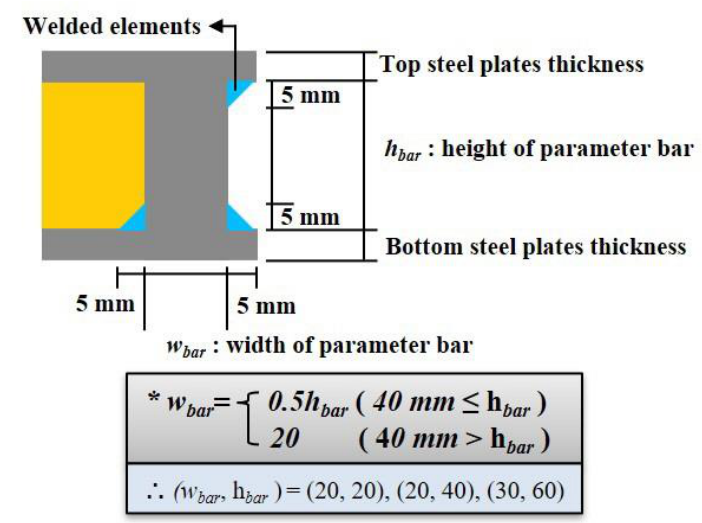
Figure 9. Detailed description of parameter bars.